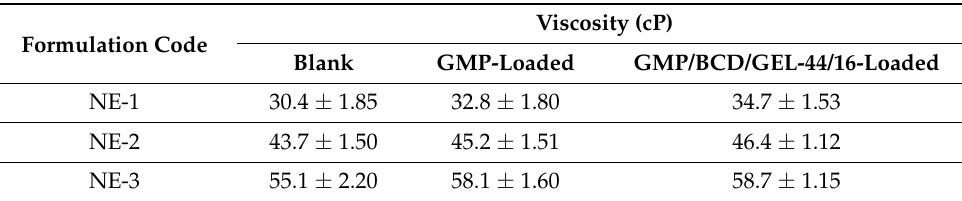
Table 4. Viscosity analysis of blank (B), glimepiride-loaded (GMP), and inclusion complex-loaded (IC) nanoemulsions (Mean ± SD, n = 3).